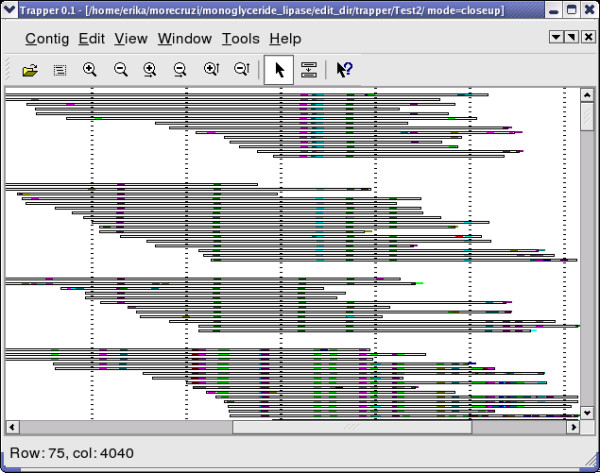
Four of the 25 different repeat groups found after manual repeat resolution. A coverage analysis of the different groups indicate that the majority of the repeat units are present in copy numbers of one or two, with an additional three units with copy number three to eight.